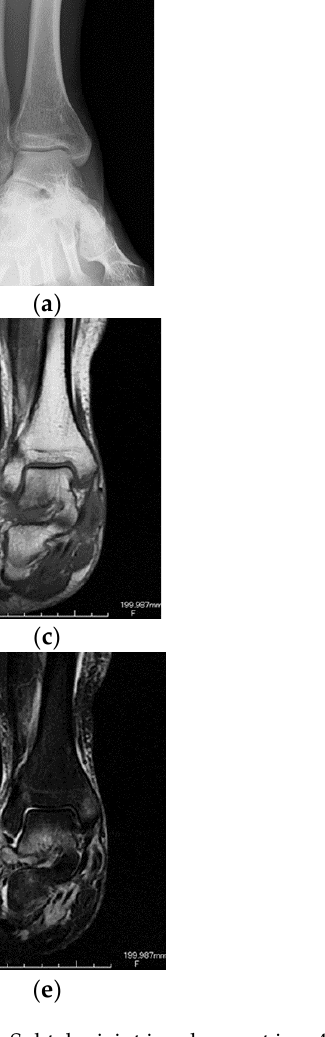
Figure 1. Subtalar joint involvement in a 47-year-old female. Anteroposterior ( a ) and lateral ( b ) plain radiographs of the right ankle joint. Coronal T1-weighted ( c ), sagittal T1-weighted ( d ), coronal fat-suppressed T2-weighted ( e ), and sagittal fat-suppressed T2-weighted ( f ) images of the right ankle joint using magnetic resonance imaging (MRI). MRI images show a moderate subtalar joint effusion with bone marrow edema.